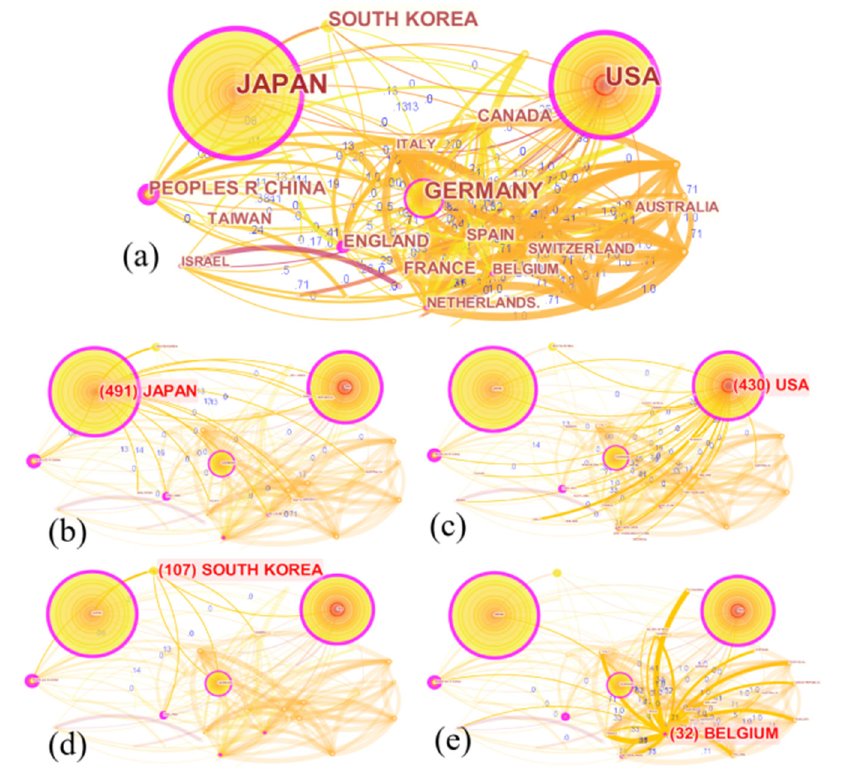
Figure 3. A visualization of the country collaboration network: ( a ) all countries/regions; ( b ) Japan; ( c ) USA; ( d ) South Korea; ( e ) Belgium.